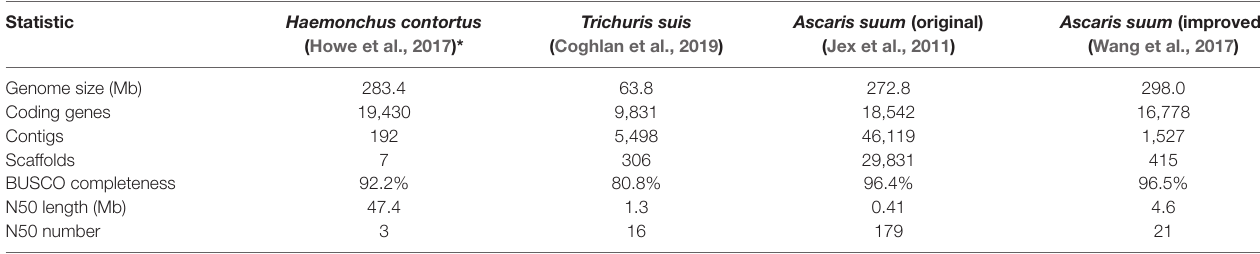
TABLE 1 | Genome statistics for core helminth species used to study intestinal functions.